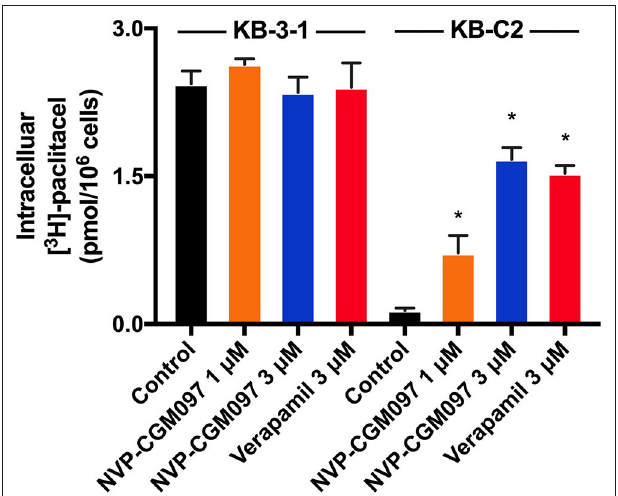
FIGURE 3 | NVP-CGM097 increased the intracellular [ 3 H]-drug accumulation in cancer cells ABCB1-overexpressing. The effect of NVP-CGM097 on the accumulation of [ 3 H]-paclitaxel in KB-3-1 and KB-C2 cells. Verapamil (3 µ M) were used as positive controls for ABCB1-overexpressing cells. Data are mean ± SD, representative of three independent experiments. * p < 0.05, compared with control group.